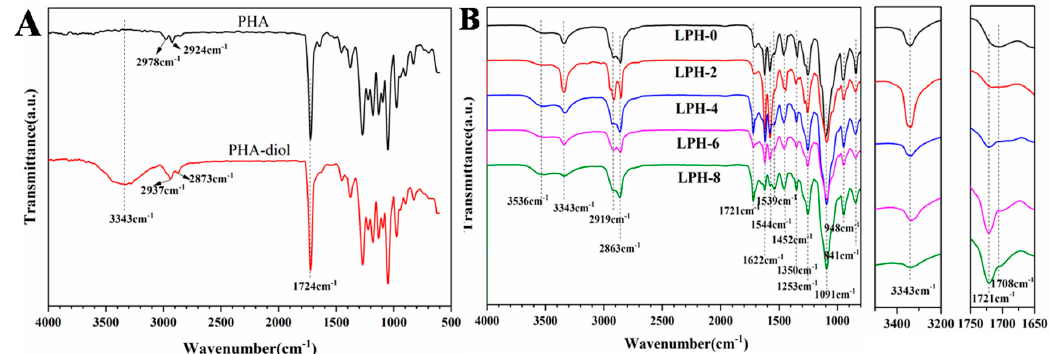
Figure 3. ATR ‐ FTIR spectra of ( A ) PHA, PHA ‐ diol,and( B ) LPH films. Figure 3. ATR-FTIR spectra of ( A ) PHA, PHA-diol, and ( B ) LPH